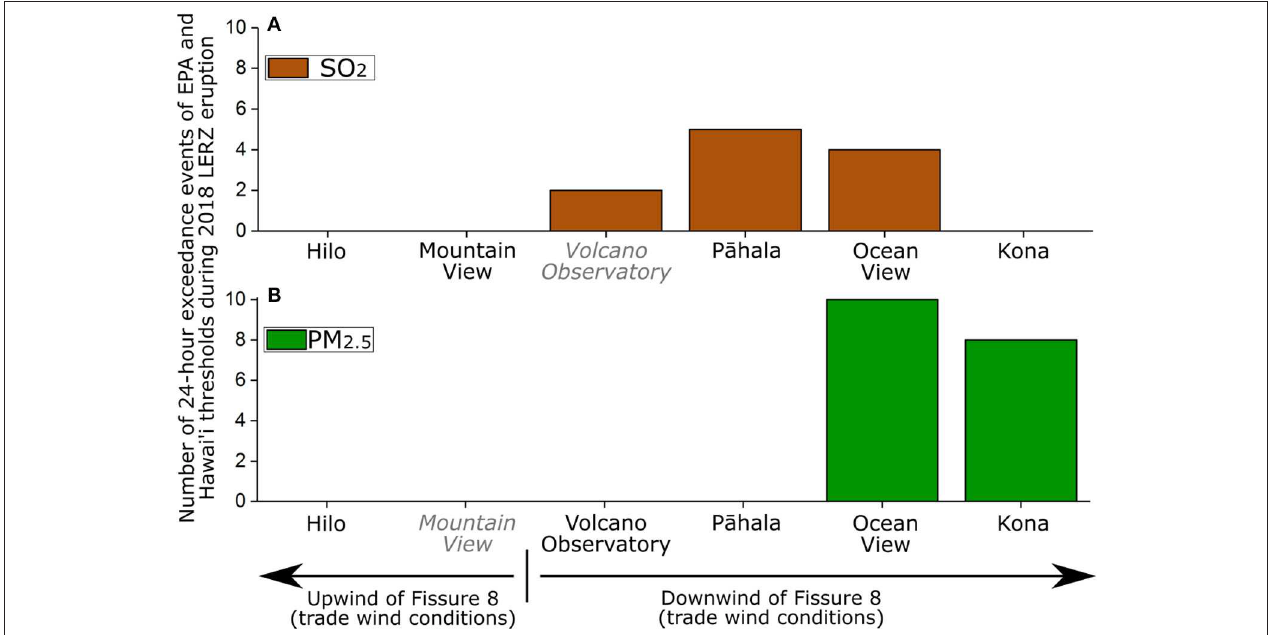
FIGURE 4 | Exceedances of (A) 24-h Hawai’i Standard for SO 2 during 2018 LERZ eruption and (B) EPA threshold for PM 2.5 during 2018 LERZ eruption. Note: data were unavailable for PM 2.5 at Volcano Observatory and SO 2 at Mountain